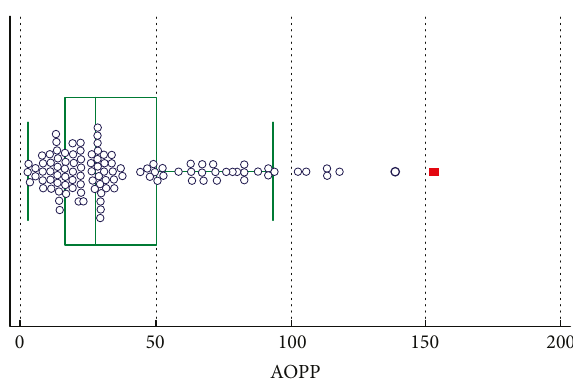
Figure 1: Box and whisker plot for AOPP.